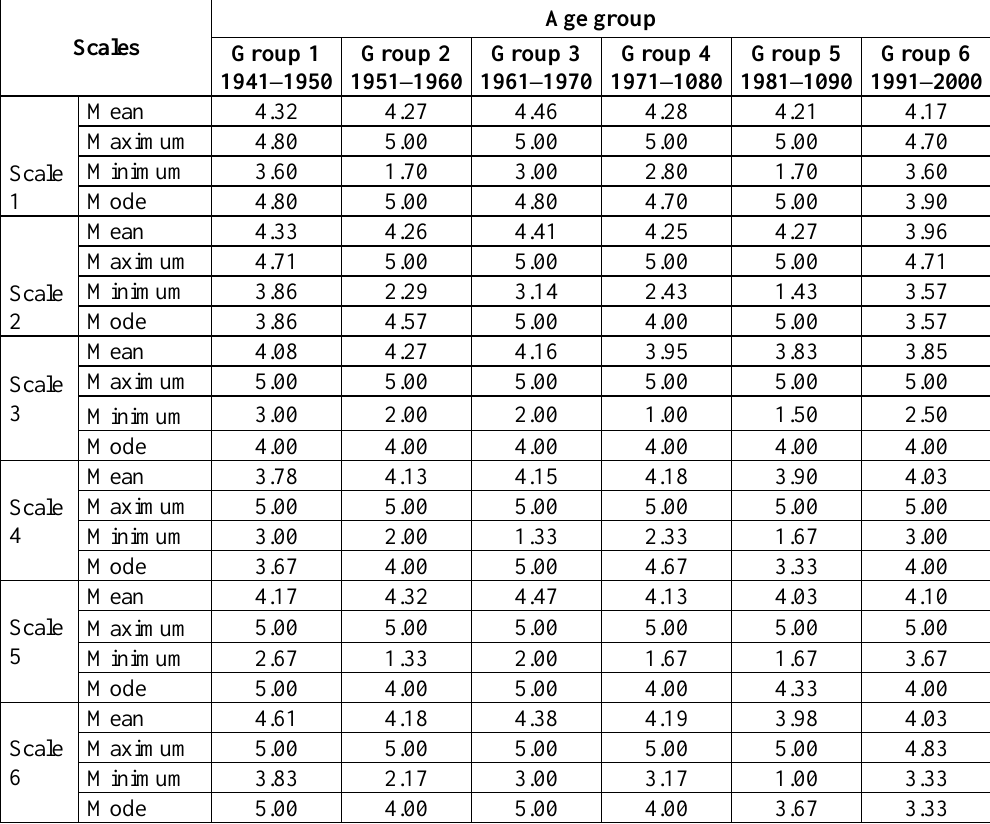
Table 4. Relationships between Scales of CCQ Questionnaire by Different Age